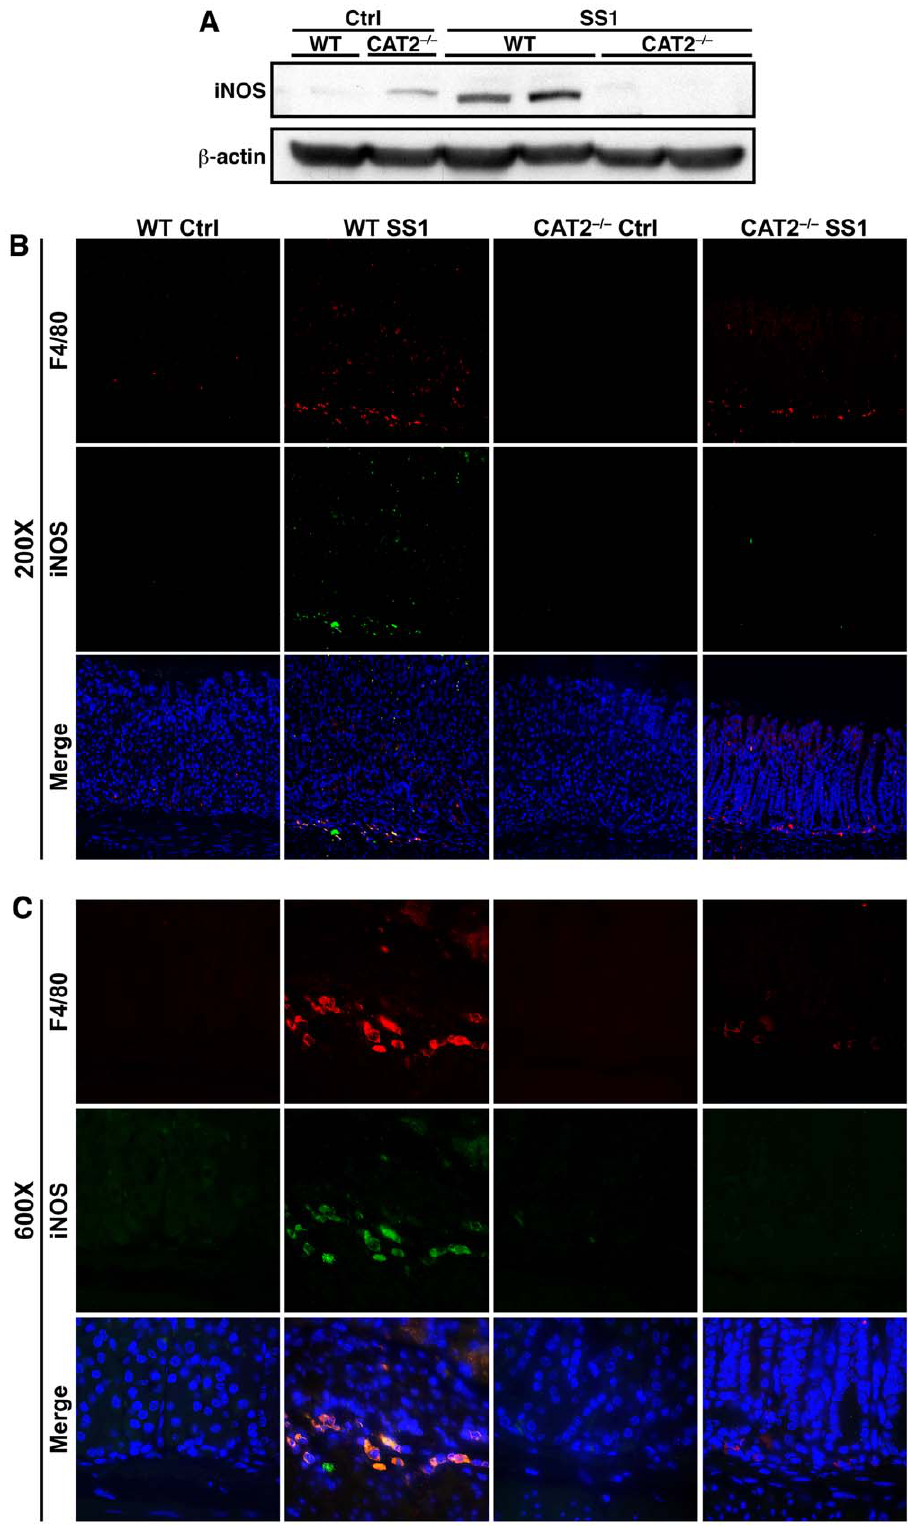
Figure 3. Chronically infected CAT2 2 / 2 mice express lower levels of iNOS protein in gastric macrophages. (A) Protein was isolated from gastric tissue of mice infected for 4 months with H. pylori SS1 and from uninfected controls. Western blot analysis was performed to detect iNOS and b -actin in total tissue lysates. (B) Pieces of glandular stomach tissue from mice 4 months post-inoculation and controls were sectioned, mounted, and stained for immunofluorescence. F4/80 was detected with TRITC-tagged antibody (red), iNOS was identified with FITC-tagged antibody (green), and nuclei were stained with DAPI (blue). In the merged images yellow coloring surrounding blue nuclei indicates colocalization of F4/80 and iNOS within cells. Representative photomicrographs were captured at 200 6 . (C) High power images (600 6 ) of the same sections. doi:10.1371/journal.pone.0029046.g003 PLoS ONE |